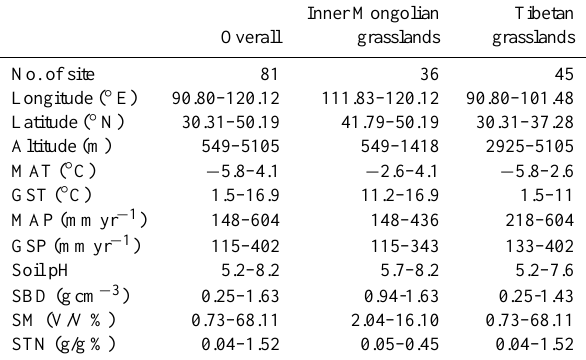
Table 1. Description of the study regions. Mean annual temperature (MAT), mean annual precipitation (MAP), growing season temper- ature (GST), growing season precipitation (GSP), Averaged topsoil pH, soil bulk density (SBD), soil moisture (SM) and soil total nitro- gen (STN) of the sampling sites are shown. Inner Mongolian Tibetan Overall grasslands grasslands